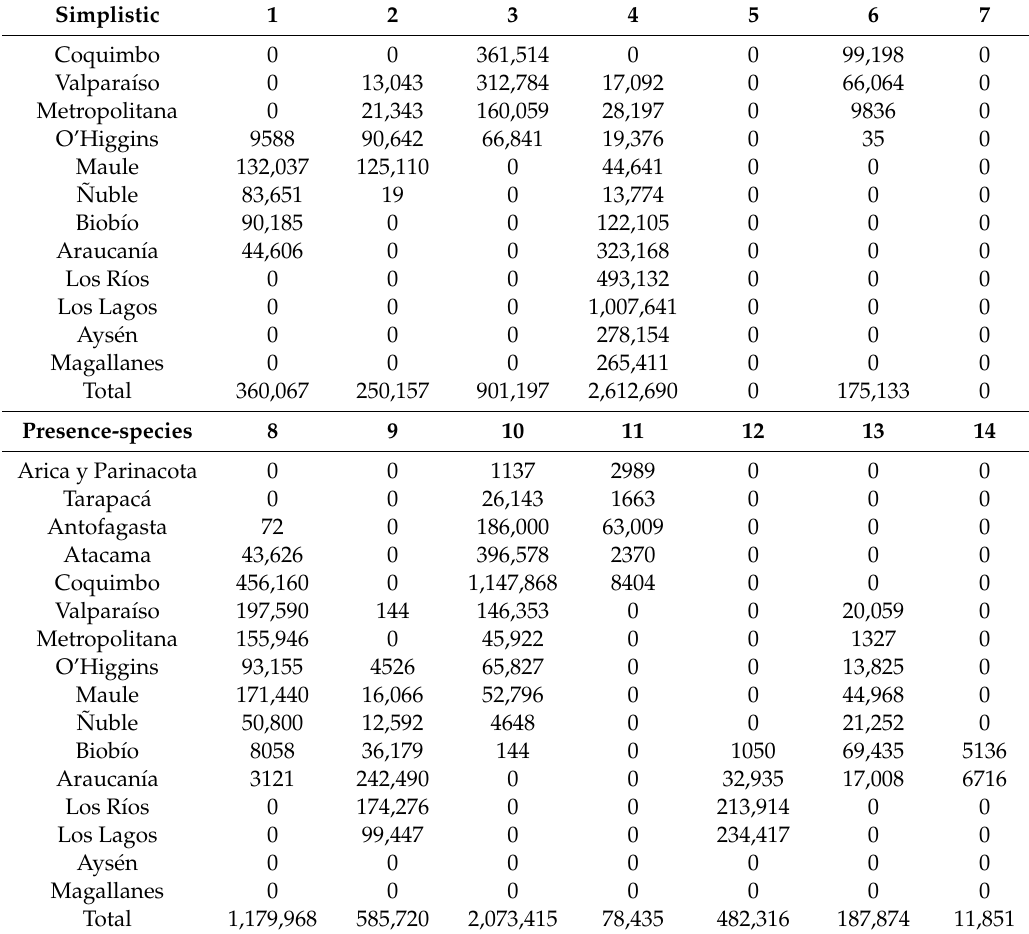
Table 5. Regional surface area with agro–climatic aptitude for castor bean production as a national oil-seed crop (ha), both with the simplistic and the presence-species methodologies. Chilean total area: 75.29 million